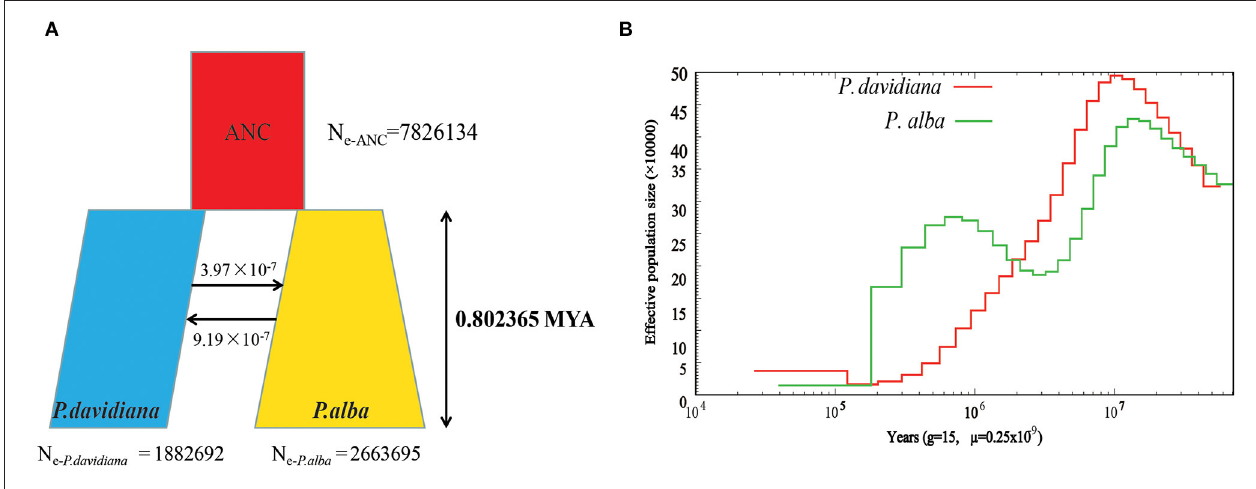
FIGURE 2 | (A) Best-fitting model inferred demographic histories and differentiation mode for Populus davidiana and P. alba implemented by fastsimcoal 2.6.1. (B) The effective population size (Ne) over historical time implementing by PSMC.